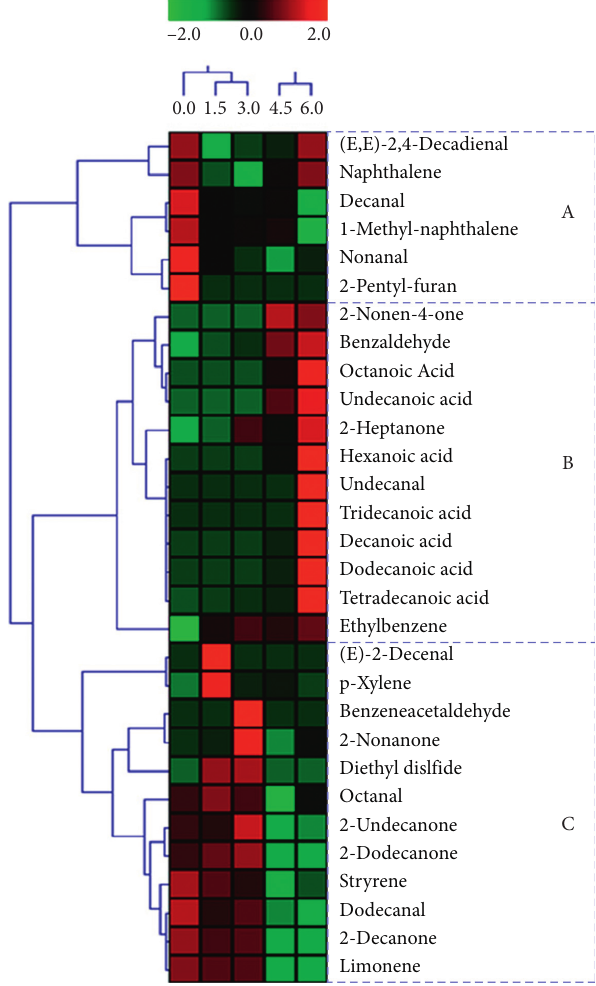
Figure 2: Heat map plots clusters of volatile compounds in yogurt fermented by S. thermophilus at different time points based on the OAVs. Green colors indicate that volatile compound levels were less than the mean levels during yogurt fermentation, while red colors indicate that volatile compound levels were higher than the mean